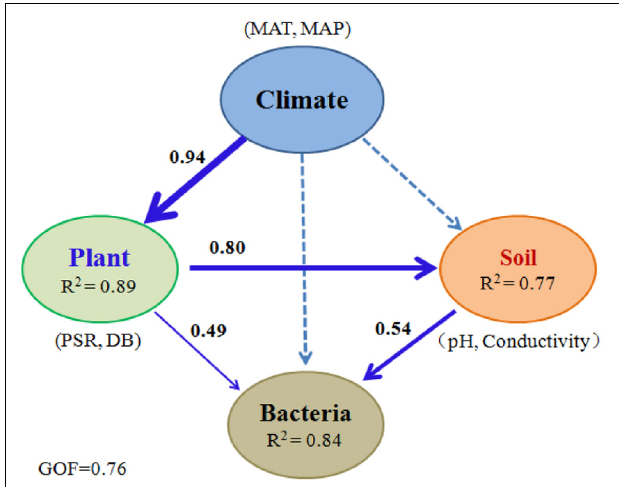
FIGURE 3 | Direct and indirect effects of climate, vegetation, and soil attributes on bacterial communities. PLS-PM was performed for bacterial communities in 99 soil samples collected along the elevational gradients. The width of arrows is proportional to the strength of path coefficients. Continuous and dashed arrows indicate significant and nonsignificant relationships, respectively. R 2 denotes the proportion of variance explained. MAT, mean annual air temperature; MAP, mean annual precipitation; PSR, plant species richness; DB, the percentage of total DBH for DB trees.